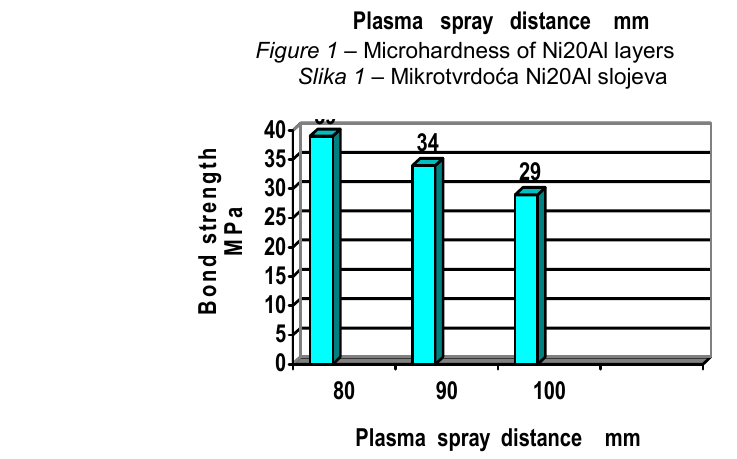
Figure 1 – Microhardness of Ni20Al layers